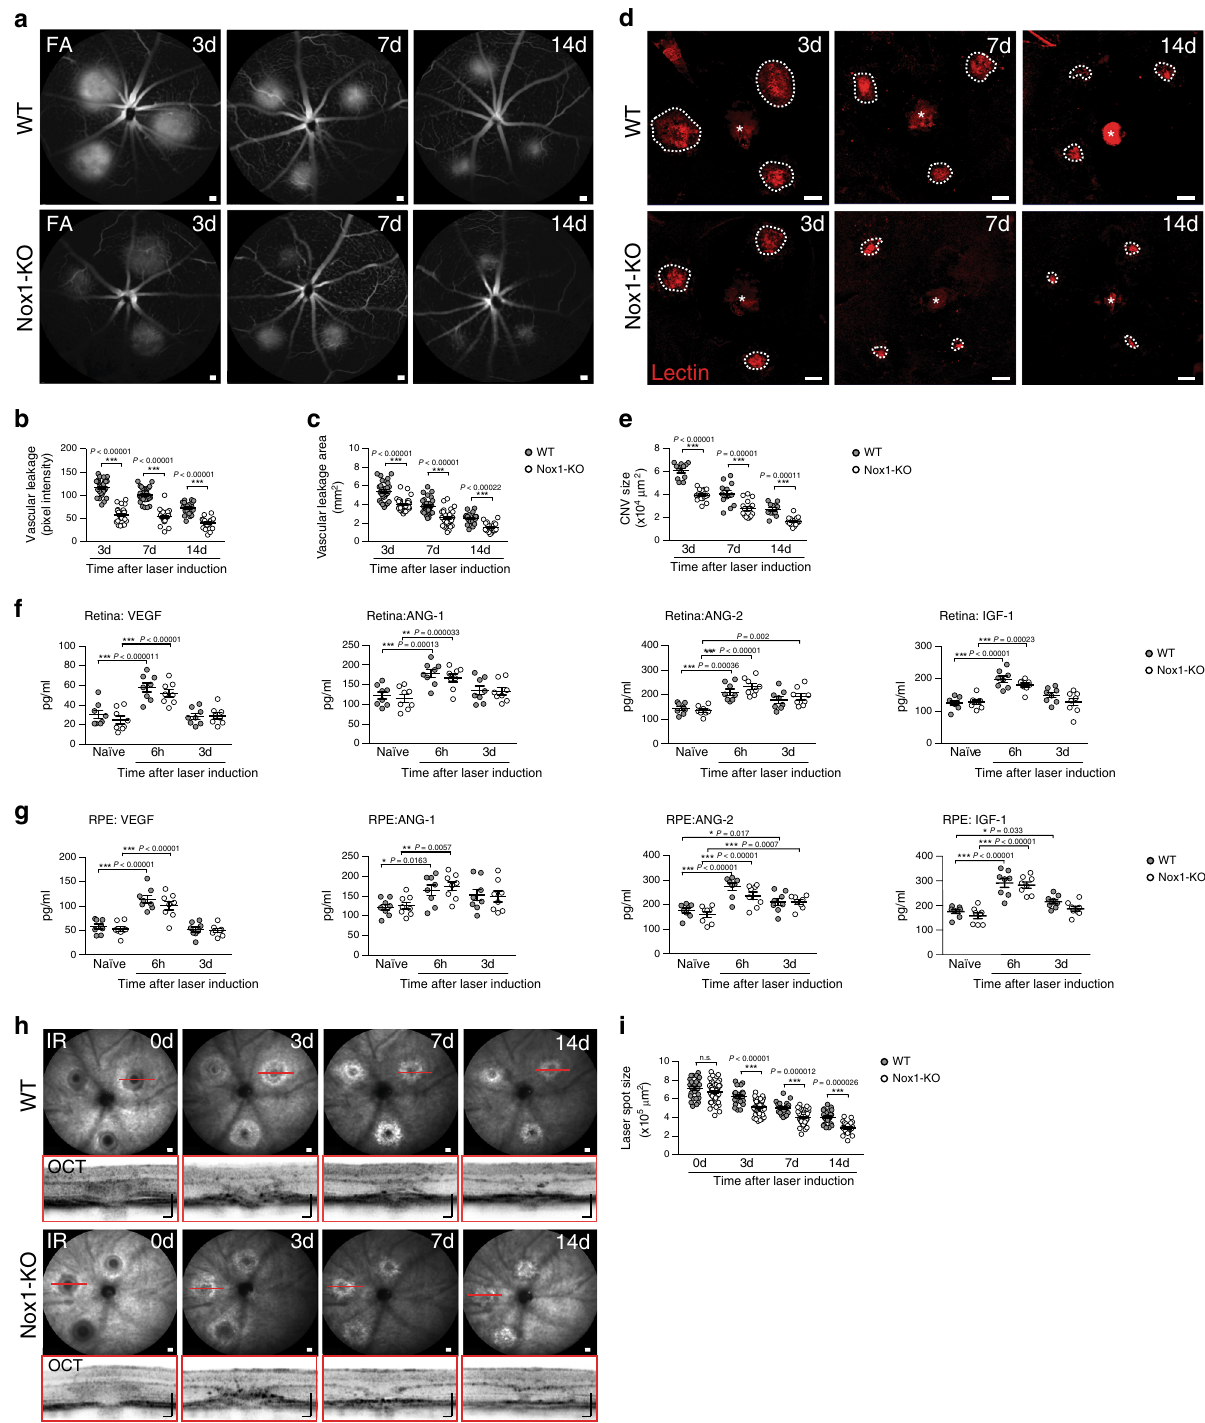
Fig. 8 NOX1 de fi ciency limits laser-induced vascular leakage and pathological CNV in mice. a Representative late phase fundus fl uorescein angiography (FFA) images at indicated time points post laser injury. Scale bar: 200 µ m. b Quanti fi cation of vascular leakage intensity after laser-induced CNV. 3 d/7 d n = 32 and 14 d n = 22 eyes from individual mice. c Quanti fi cation of vascular leakage area after laser-induced CNV. 3 d/7 d n = 32 and 14 d n = 22 eyes from individual mice. d Representative laser-induced CNV stained with isolectin B4 in RPE/choroidal fl at mounts. Scale bar: 100 µ m; FA fl uorescein angiography. e Quanti fi cation of laser-induced CNV area in RPE/choroidal fl at mounts. WT/Nox1-KO n = 12/18 RPE/choroids from individual mice. f Pro- angiogenic growth factor levels in retinas of naïve and lasered WT and Nox1-KO mice at indicated time points. n = 8 eyes from individual mice. g Pro- angiogenic growth factor levels in RPE/choroids of naïve and lasered WT and Nox1-KO mice at indicated time points. n = 8 eyes from individual mice. h Representative infrared (IR) fundus images at indicated time points post laser injury. Lower panel shows OCT scan from one laser spot marked by a red line. Scale bar: 200 µ m. I Quanti fi cation of laser spot size. WT/Nox1-KO 0 d n = 28/68, 3 d n = 22/51, 7 d n = 22/45,14 d n = 22/25, n = 25 eyes from individual mice. Data show mean ± SEM. A linear mixed model was used for statistical analyses, * P < 0.05; ** P < 0.01; and *** P ≤ 0.001. n.s., not signi fi cant. Source data are provided as a Source Data fi